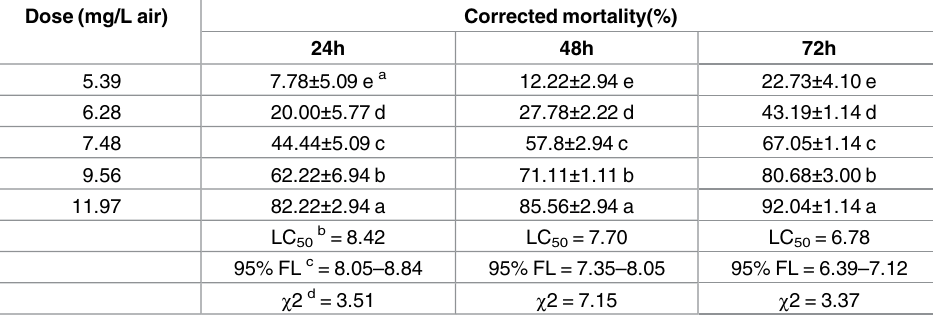
Table 1. Fumigant toxicity of M . alternifolia essential oil against S . zeamais adults.